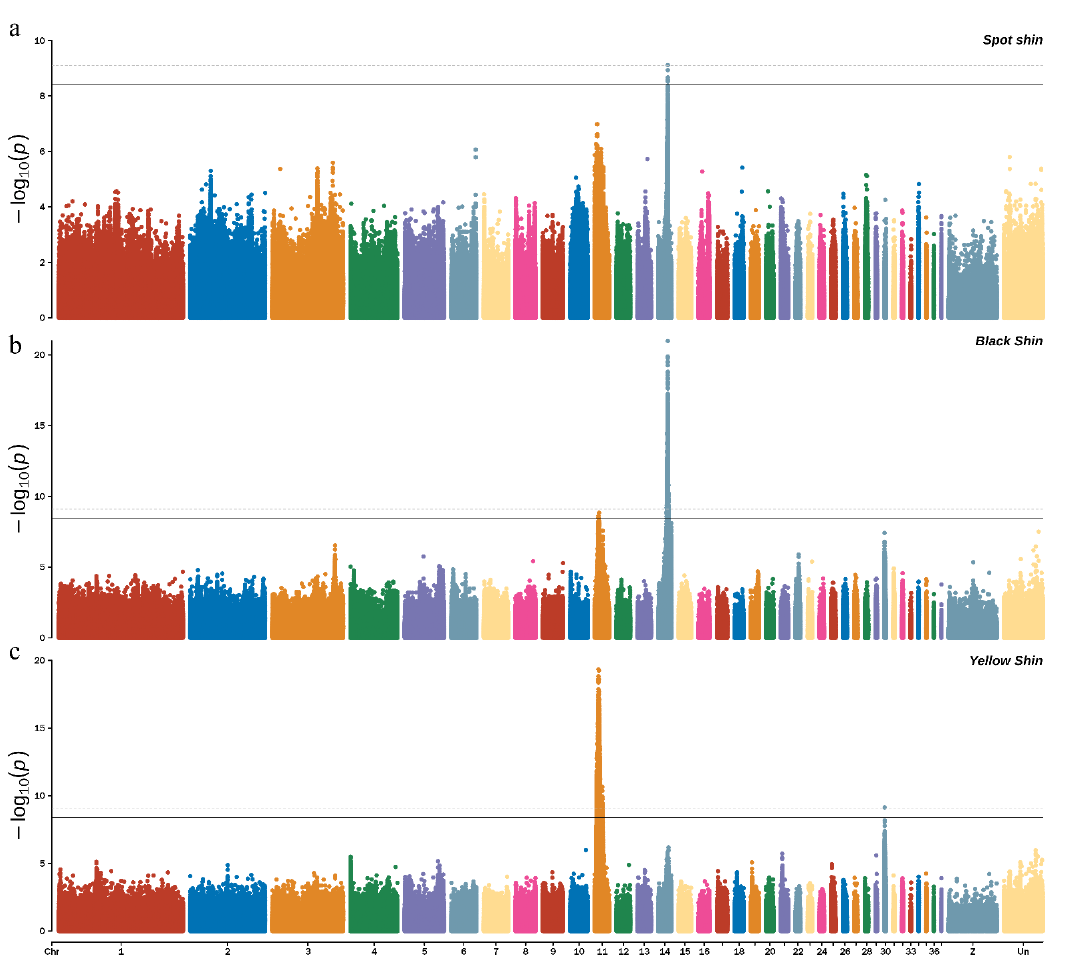
properly controlled.